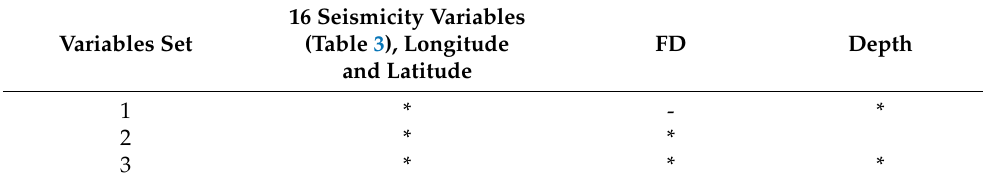
Table 5. Examined variables